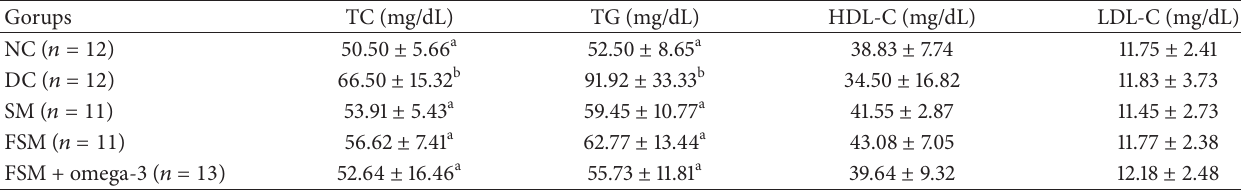
Table 3: Lipids profile of each group fed with different products.